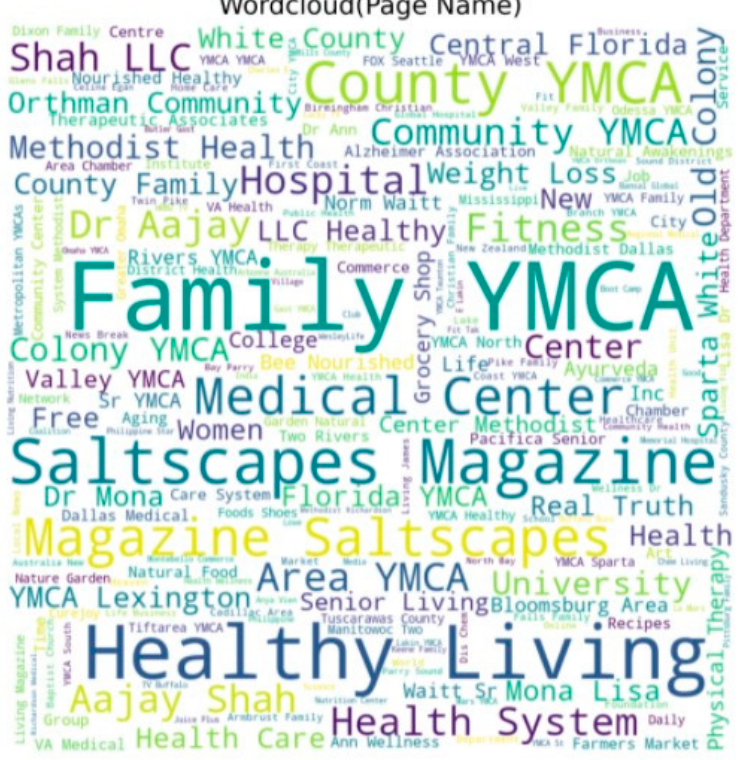
Figure 8. Page names. Word cloud representation of names of Facebook pages and groups.